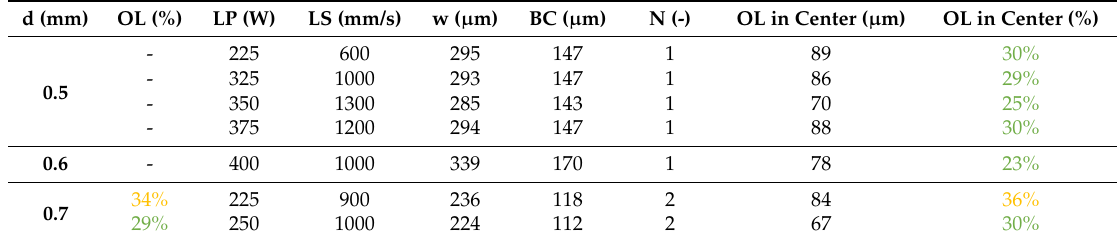
Table 3. Various suitable combination of process parameters for production of the struts with diameters 0.5–0.7 mm, ( N (-) is number of the used contour, w ( µ m) is single width × 1.25).